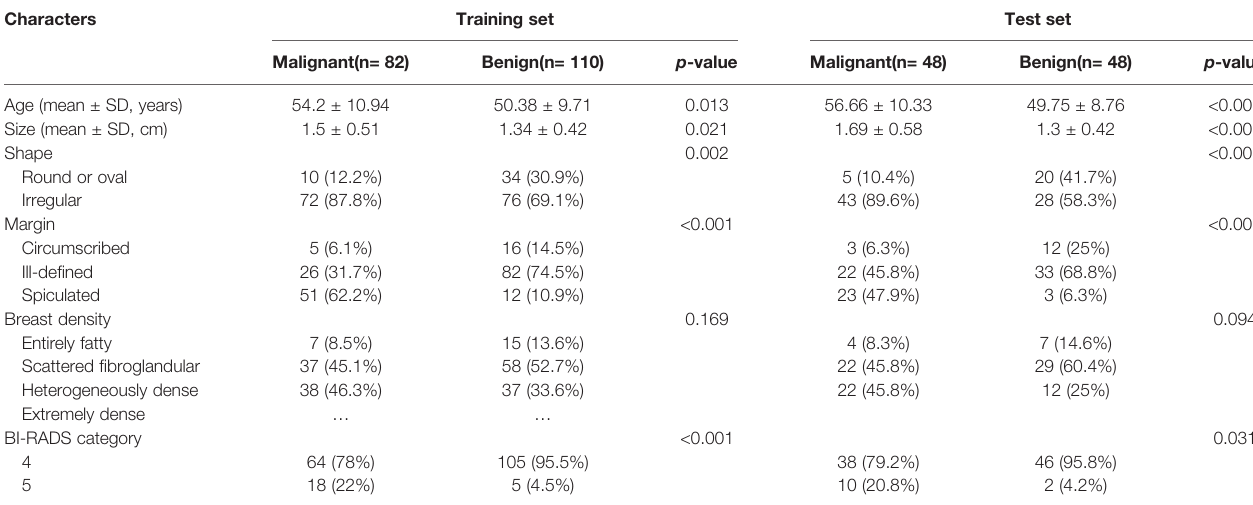
TABLE 1 | Baseline characteristics of study population in training and test sets. Characters